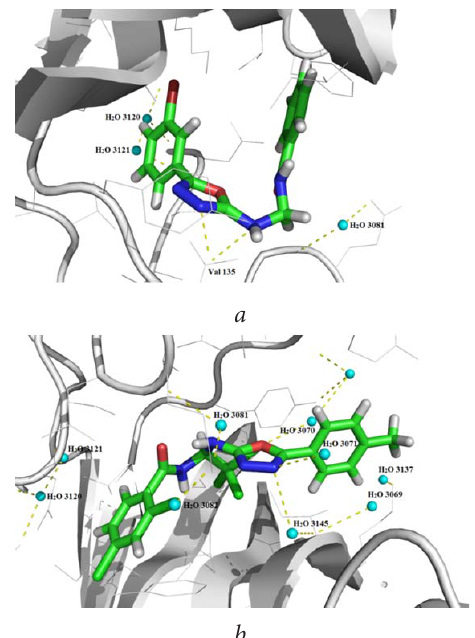
Fig. 3. Position of N -amidoalkylated derivatives of 2-amino-1,3,4-oxadiazolein GSK-3β active site according to the results of molecular